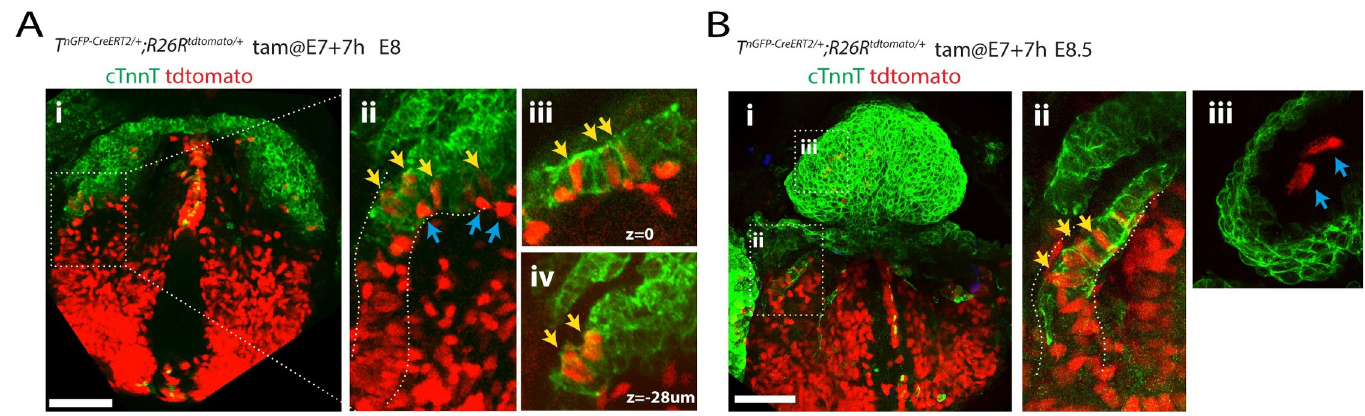
Fig 2. Descendants from late E7+7h T-positive primitive streak cells contribute to posterior regions of the FHF. (A, B) Representative embryos resulting from the administration of tamoxifen at E7+7h in T nGPF-CreERT2/+ ; R26R tdTomato/+ immunostained with cTnnT to reveal the cardiomyocytes of the first heart field (green) (A) and heart tube (B). Yellow arrows identify tdTomato-positive cardiomyocytes in the posterior first heart field (Aii–Aiv) and inflow tract (Bii). Blue arrows identify tdTomato- positive endodermal cells (Aii) and endocardial cells (Biii). (Aii) shows magnified view of inset in (Ai). (Ai–Aii and Bi–Bii) are z-maximum projection, (Aiii–Aiv and Biii) are single optical sections. Views are ventral. Single epicardial cells are labelled in each condition. Scale bar: 200 μ m.